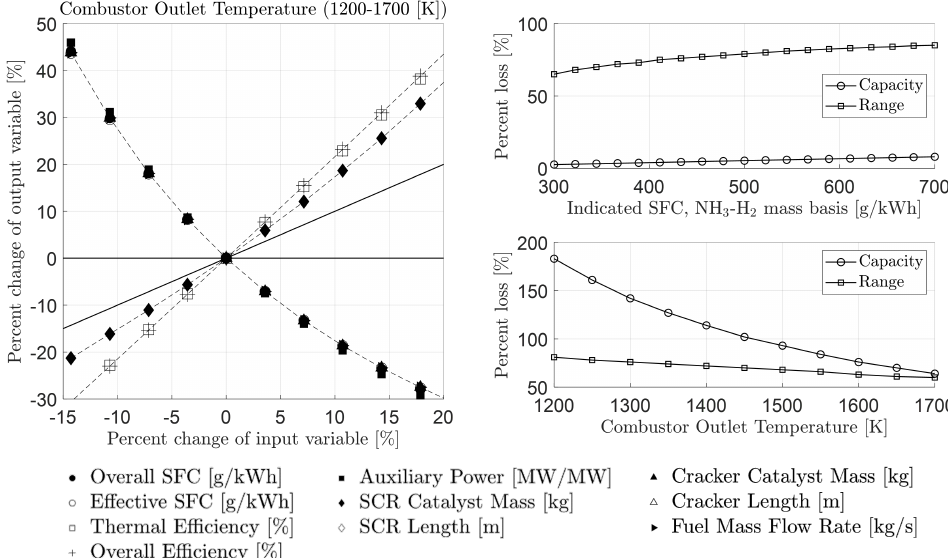
Figure 17. ( left ) The relative change in relevant output values with respect to the relative change of one input value, in this case, the GT combustor exit temperature. ( right ) A comparison of how changes to ICE input indicated SFC and GT combustor exit temperature impact the loss of range and capacity of an ICE-powered New Panamax vessel ( top ) and a GT-powered naval frigate ( bottom ). The nominal values for input indicated SFC, exhaust gas temperature, and